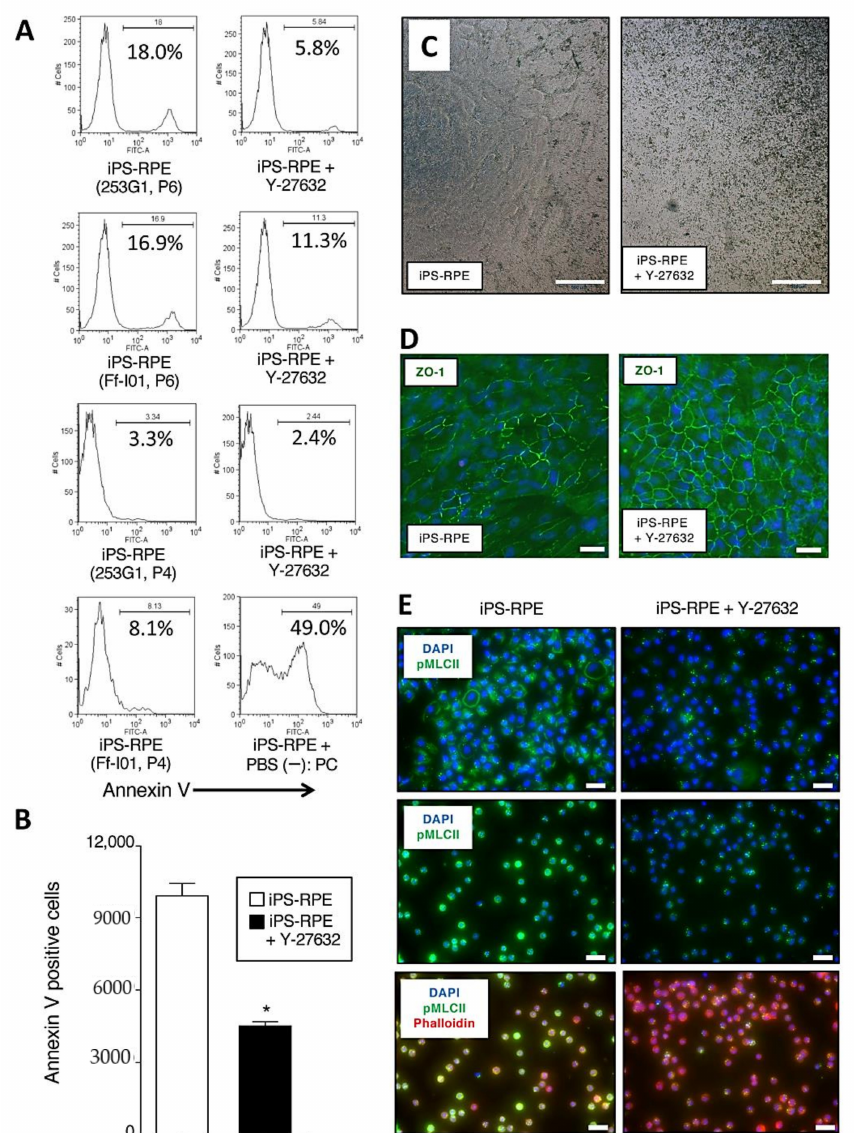
Figure 2. Apoptosis, pigmentation, and detection of ZO-1 and pMLCII in Y-27632-pretreated iPS-RPE cells. (A ) iPS-RPE cells (253G1, Ff-I01 lines) were treated with Y-27632 (10 µ M) for 24 h. Compared with nontreated RPE cells, Y-27632-treated RPE cells exhibited fewer annexin V-positive cells in flow cytometry. P4 or P6: passaged 4 or 6 times. As a positive control (PC), RPE cells in the presence of PBS (-) were also prepared. ( B ) There were significant differences between Y-27632-treated and nontreated iPS-RPE cells (253G1, P6) in annexin V FACS analysis. Data represent the mean ± SEM of three independent experiments, and we obtained similar results with other iPS-RPE cell lines (TLHD2 lines). * p <0.05 between two groups. ( C ) Pigmentation of the Y-27632-treated RPE cells (454E2 lines). Compared with nontreated cells, RPE cells in the presence of Y-27632 (added once per week in 4-week cultures) had much pigmentation. We did not obtain quantitative and statistics data, but we obtained similar results with other iPS-RPE cell lines (453F2, TLHD2 lines). These pictures are blight filed images by microscope. Scale bar = 500 µ m. ( D ) Y-27632 treated iPS-RPE cells more clearly expressed ZO-1 (green) than nontreated cells. Scale bar = 50 µ m. ( E ) Detection of phospho-myosin light chain 2 (pMLCII) in Y-27632-treated iPS-RPE cells. IHC for pMLCII (green) in human iPS-RPE cells without (left) or with (right) 10 µ M Y-27632. Cells were counterstained with phalloidin (red) and DAPI (blue). These RPE cells were seeded onto Laminin E8 fragment (iMatrix511: higher panels)-coated and noncoated plates (middle panels). The lower panels also show staining with phalloidin (red) together with pMLCII (green). We obtained similar results with other iPS-RPE cell lines (453F2, TLHD2 lines). Scale bar = 50 µ